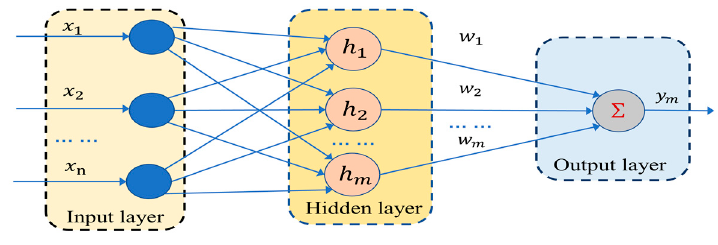
Figure 5. structure of radial basis function neural network. Figure 5. Structure of radial basis function neural